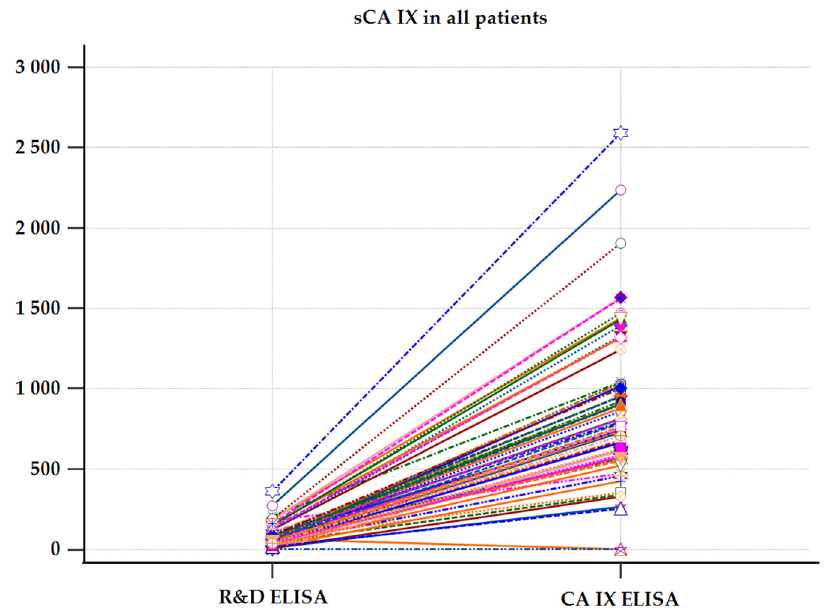
Figure A8. Comparison of R&D ELISA test versus CA IX ELISA. Dot and line diagram of pairwise comparison shows sCA IX concentrations of individual patients (each patient marked with an individual point symbol) measured by R&D ELISA (left) versus CA IX ELISA (right).